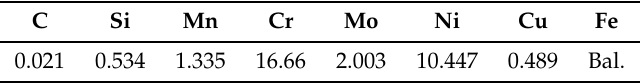
Table 1. Measured chemical composition of 316L steel [ wt % ] .